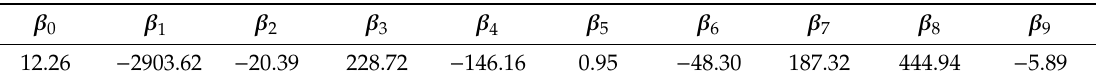
Table 5. Value of regression coe ffi cients for Equation (2) in the Aizu Basin. β